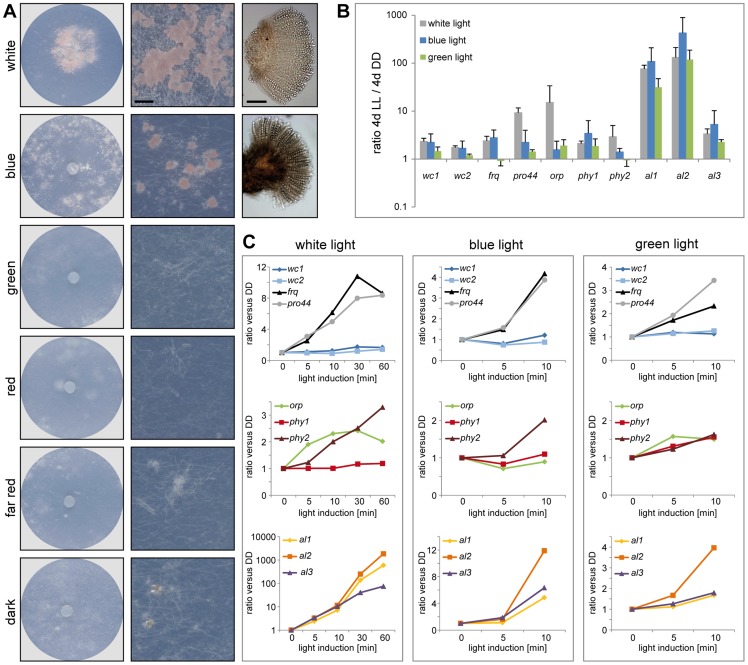
Fruiting body development and gene expression under different light regimes.
A. Fruiting body development in P. confluens is blue light-dependent. P. confluens was grown on minimal medium in constant light of different wavelengths as indicated (for filter characteristics see Figure S8). The left column shows petri dishes, the middle column sections from petri dishes (bar 500 µm), and the right column shows mature apothecia in those cases where fruiting bodies are formed (bar 100 µm). Blue light is the effective part of the visible spectrum and induces apothecia formation, similar to white light. Under other light conditions or in darkness, sometimes mycelial aggreagates are formed that can be darkly pigmented, but do not contain sexual structures (e.g. visible in section from petri dish in the dark). B and C. Expression of homologs of genes that are involved in blue light responses (wc1, wc2, frq), in light responses and/or fruiting body formation (pro44), are photoreceptors for other wavelengths (orp1, phy1, phy2) or carotenoid biosynthesis genes (al1, al2, al3) in other fungi (Table 2). Transcript levels after 4 d of illumination with white, blue, or green light compared to 4 d in darkness (DD) are shown in B, short term light induction (5–60 min after growth in darkness for 4 d) in C. P. confluens was grown in minimal liquid medium and harvested under far-red light. Transcript levels were determined by qRT-PCR from at least two independent biological replicates; ratios versus DD samples are shown, error bars in B indicate standard deviation, for standard deviations for short term light induction in C, see Table S10.